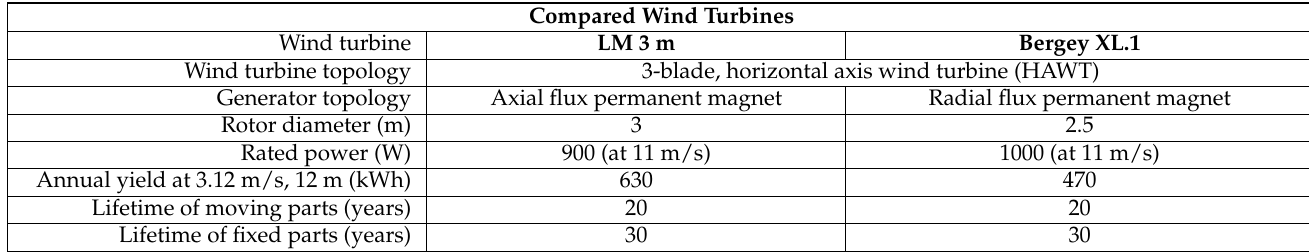
Table A1. Specifications of the compared wind